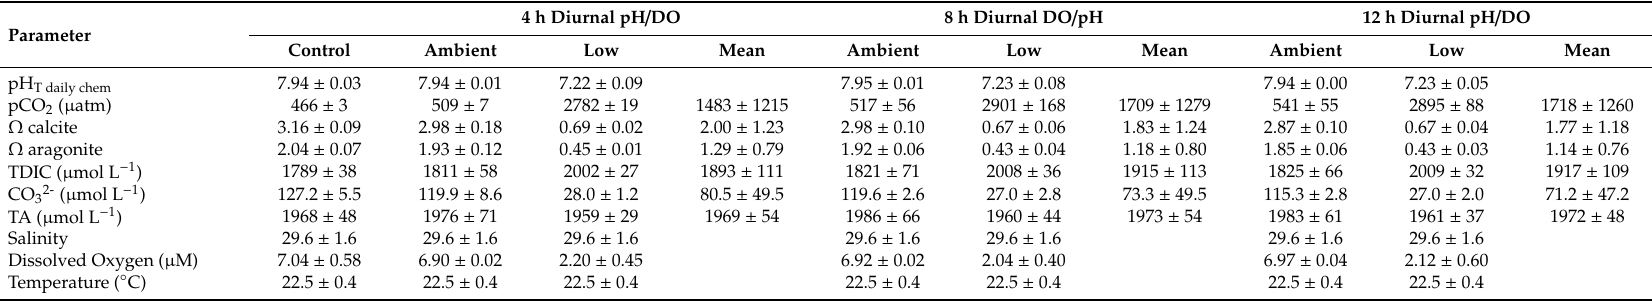
Table 6. Mean ( ± standard deviation) pH, pCO 2 , saturation states of calcite and aragonite, total dissolved inorganic carbon (TDIC), carbonate, total alkalinity (TA), salinity, dissolved oxygen, and temperature for the Menidia beryllina I four treatment diurnal duration acidification and hypoxia experiments. 4 h Diurnal pH / DO 8 h Diurnal DO / pH 12 h Diurnal pH / DO Parameter Control Ambient Low Mean Ambient Low Mean Ambient